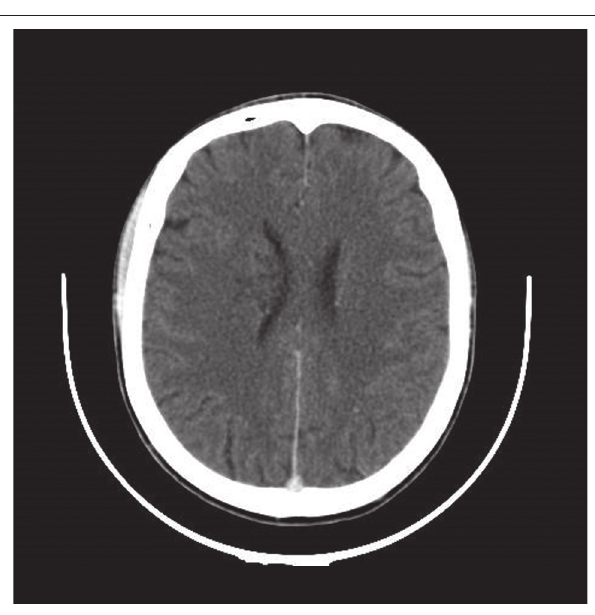
FIGURE 3: Classical soap bubble lesion in the right basal ganglia seen on this contrast-enhanced axial image.